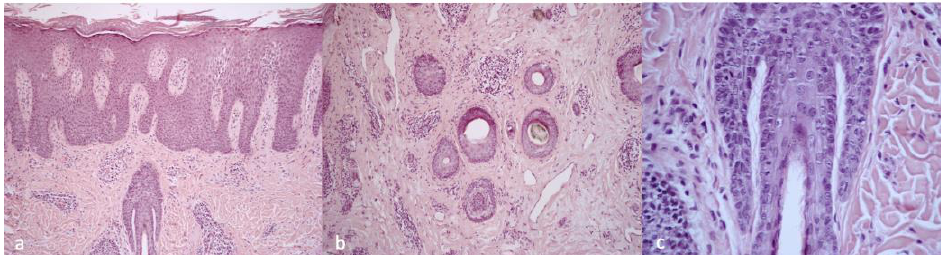
Figure 2. Histological findings of Patient 1. ( a ) Parakeratosis, focal absence of granular layer, neu- trophilic infiltrate in the papillary dermis and mantles (sebaceous structures), H&E 10× magnification; ( b ) dilated vessels in the dermis and neutrophilic infiltrate, H&E 10× magnification; and ( c ) high magnification of mantles (sebaceous structures), H&E 40× magnification.